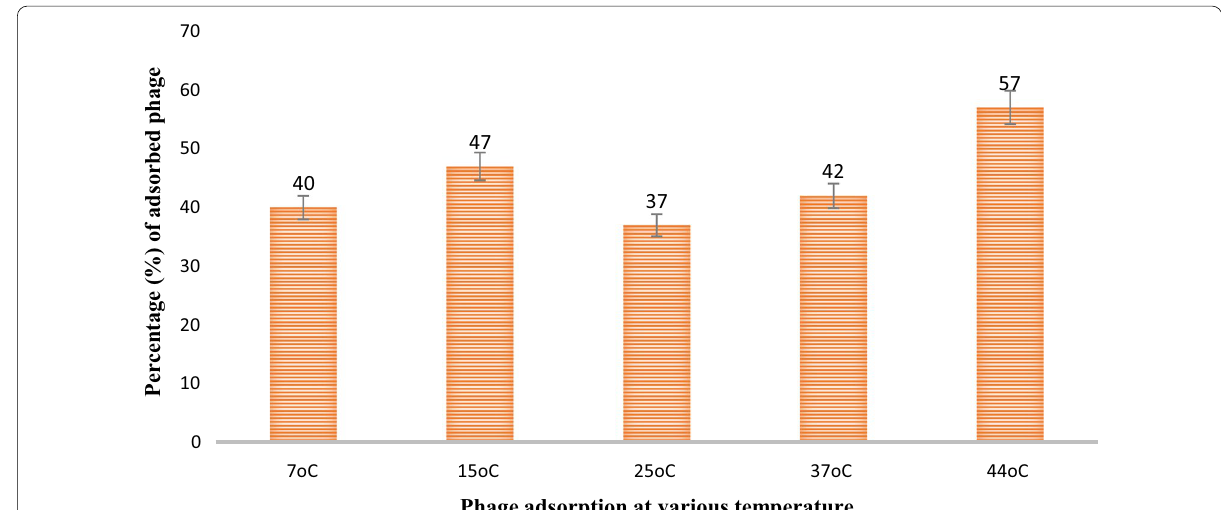
Fig. 4 ɸ PauNE1 phage adsorption at various temperatures